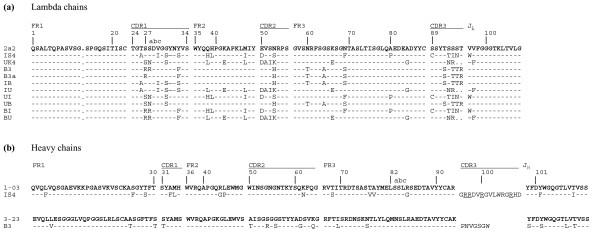
Sequence alignment of the expressed variable light chainregion (VL) and variable heavy chainregion (VH), using DNAplot software in VBASE. (a) Sequences of expressed Vλ regions compared with gene 2a2. (b) Sequences of expressed VH regions compared with genes 1-03 (IS4) and 3–23 (B3). The DH regions could not be matched to germline genes. Arginine residues altered by site-directed mutagenesis to serine residues in IS4VH complementarity determining region (CDR) 3 are underlined. Amino acids are numbered according to Kabat. Dots inserted to facilitate the alignment. Dashes indicate homology with the corresponding germline sequence. FR, framework region.